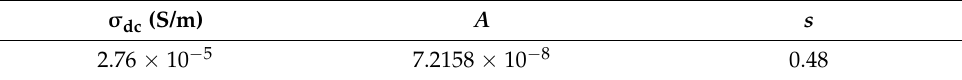
Figure 8. The ac conductivity variation of synthesized NiS along with a change in frequency. Table 1. The ac conductivity fitting parameters by Jonscher’s power